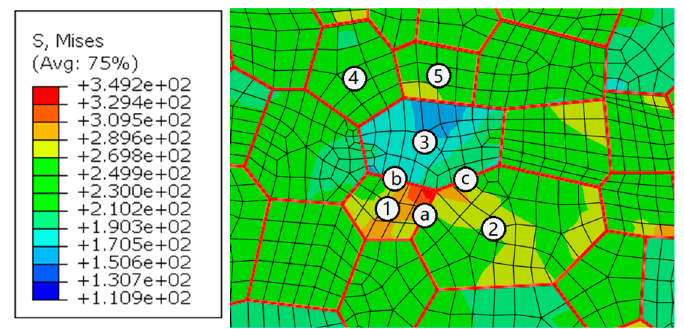
Figure 12. Stress concentration at the grain boundary marked as letter a, MPa. Table 2. The misorientations of adjacent grains in Figure 12.